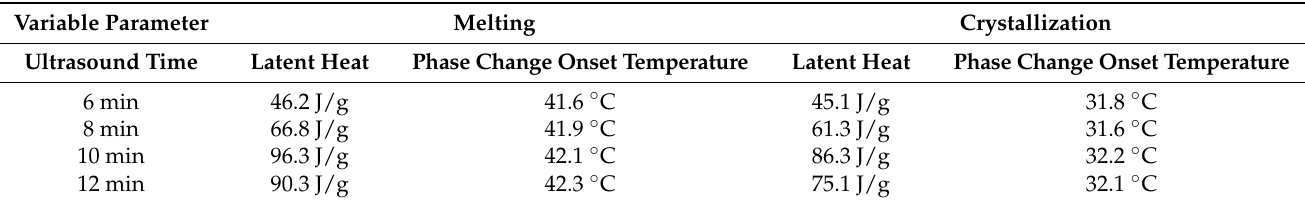
Table 6. Experimental results for changing ultrasonic oscillation